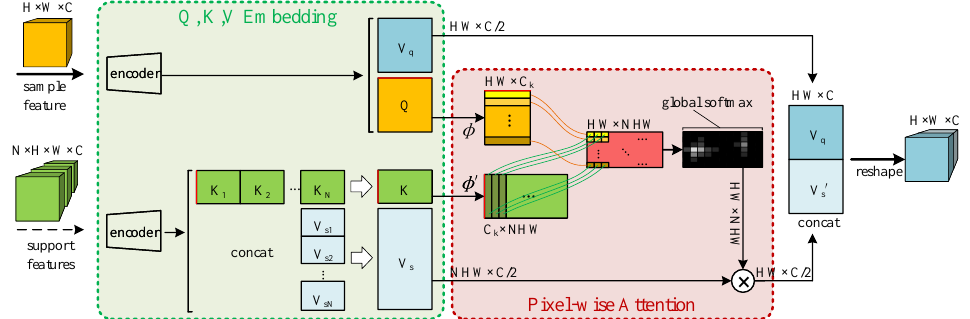
Figure 3. Feature augmentation framework. The sample and support features are first encoded into query (Q), key (K), and value (V) embedding. Two linear transformations are performed on both Q and K feature maps. Pixel-wise attention is performed to fuse the Q and K feature maps to form the final learnable similarity metric, thus retrieving co-existing information from support